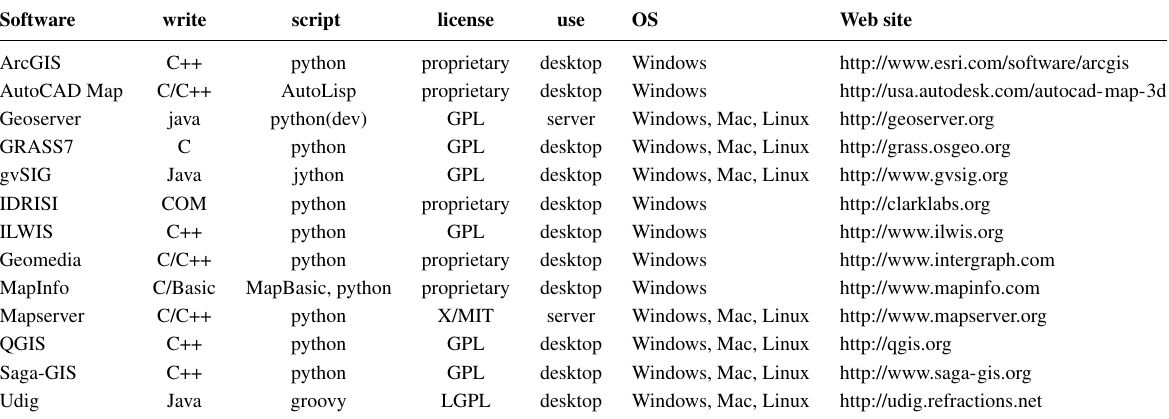
Table 2. Table with a comparison of the most used GIS